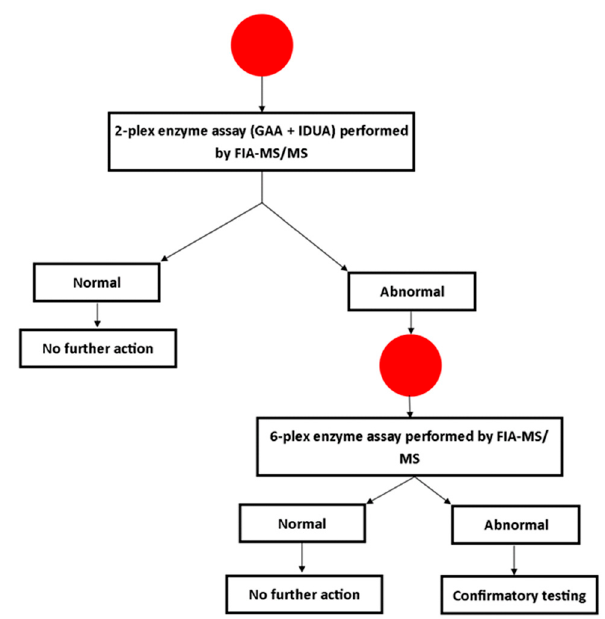
Figure 1. Laboratory testing algorithm for Georgia pilot study screening for MPS I and PD. FIA-MSMS: flow injection tandem mass spectrometry, IDUS: alpha-iduronidase, GAA: